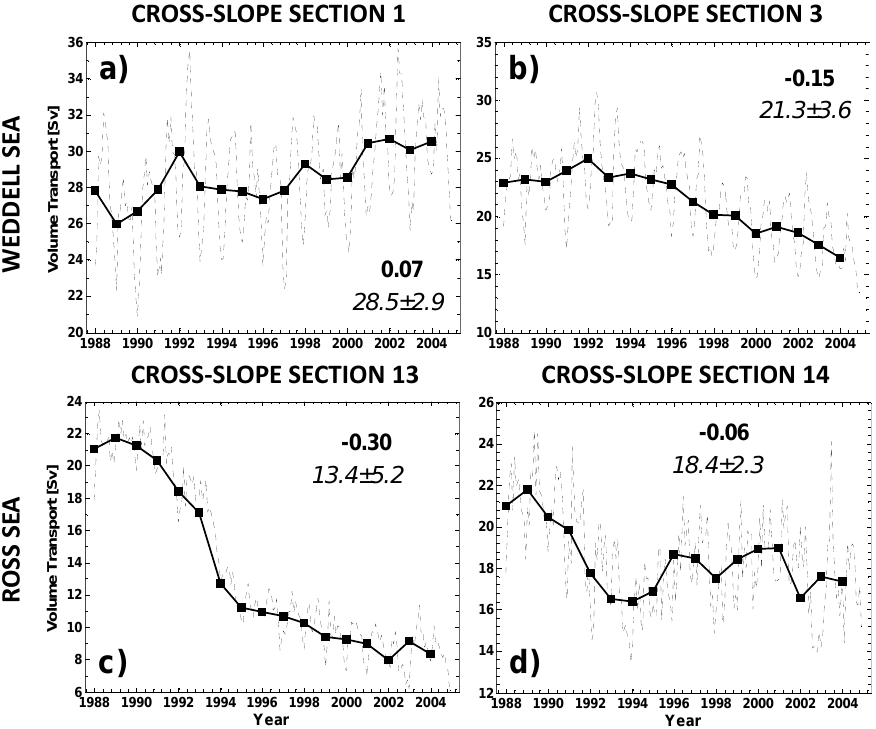
Fig. 7. Monthly (dashed line) and annual (full line) average of OCCAM full-depth cumulative volume transport for ( a and b ) Weddell and ( c and d ) Ross Seas cross-slope sections as indicated. Bold and italic annotations show respectively the decadal linear trend (Sv decade − 1 ) and the average and standard deviation for the entire